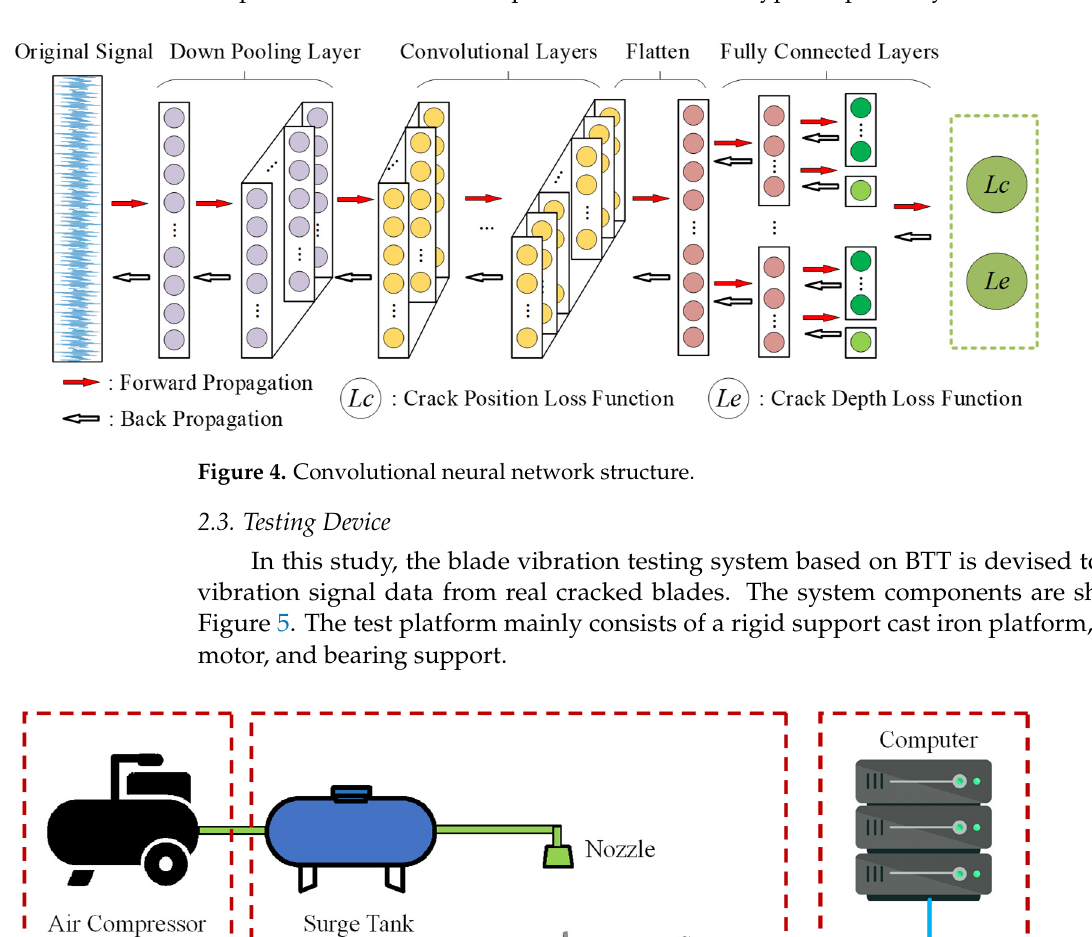
Figure 3. Method for obtaining blade tip arrival time.